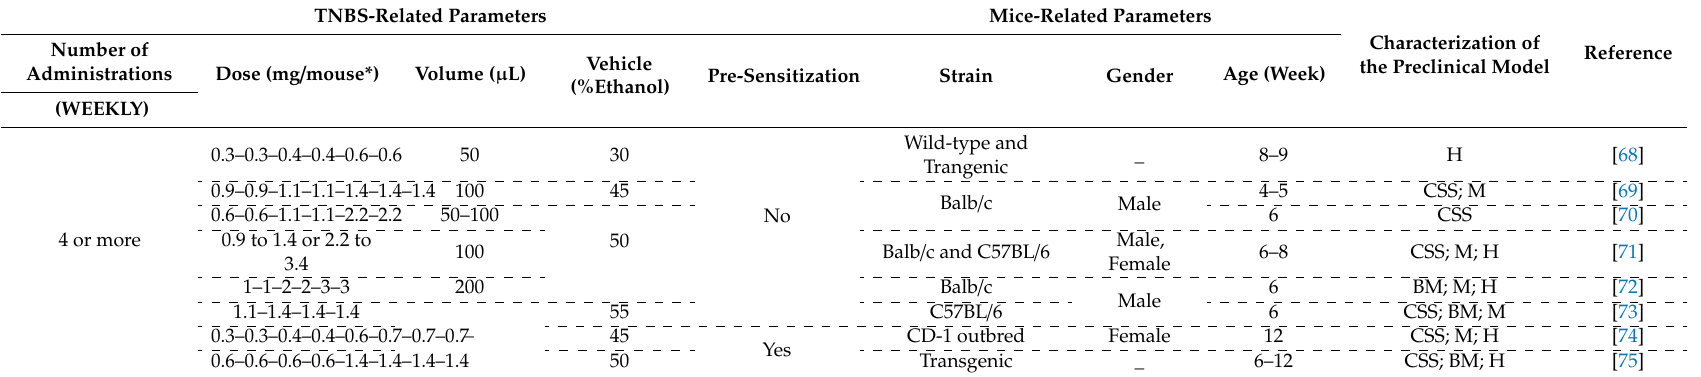
Legend: CSS: Clinical signs and symptoms (e.g., body weight, mortality, morbidity, stool consistency); BM: Biochemical markers (e.g., TNF- α , TGF- β , IL-6,10,12; IL-1 β , IFN- γ , MPO, CD4 + lymphocytes); M: Macroscopic evaluation (e.g., ulcers, thickness, hyperemia, colon weight and length); H: Histological evaluation (e.g., inflammation). * mg / mouse: each mouse weighs 20